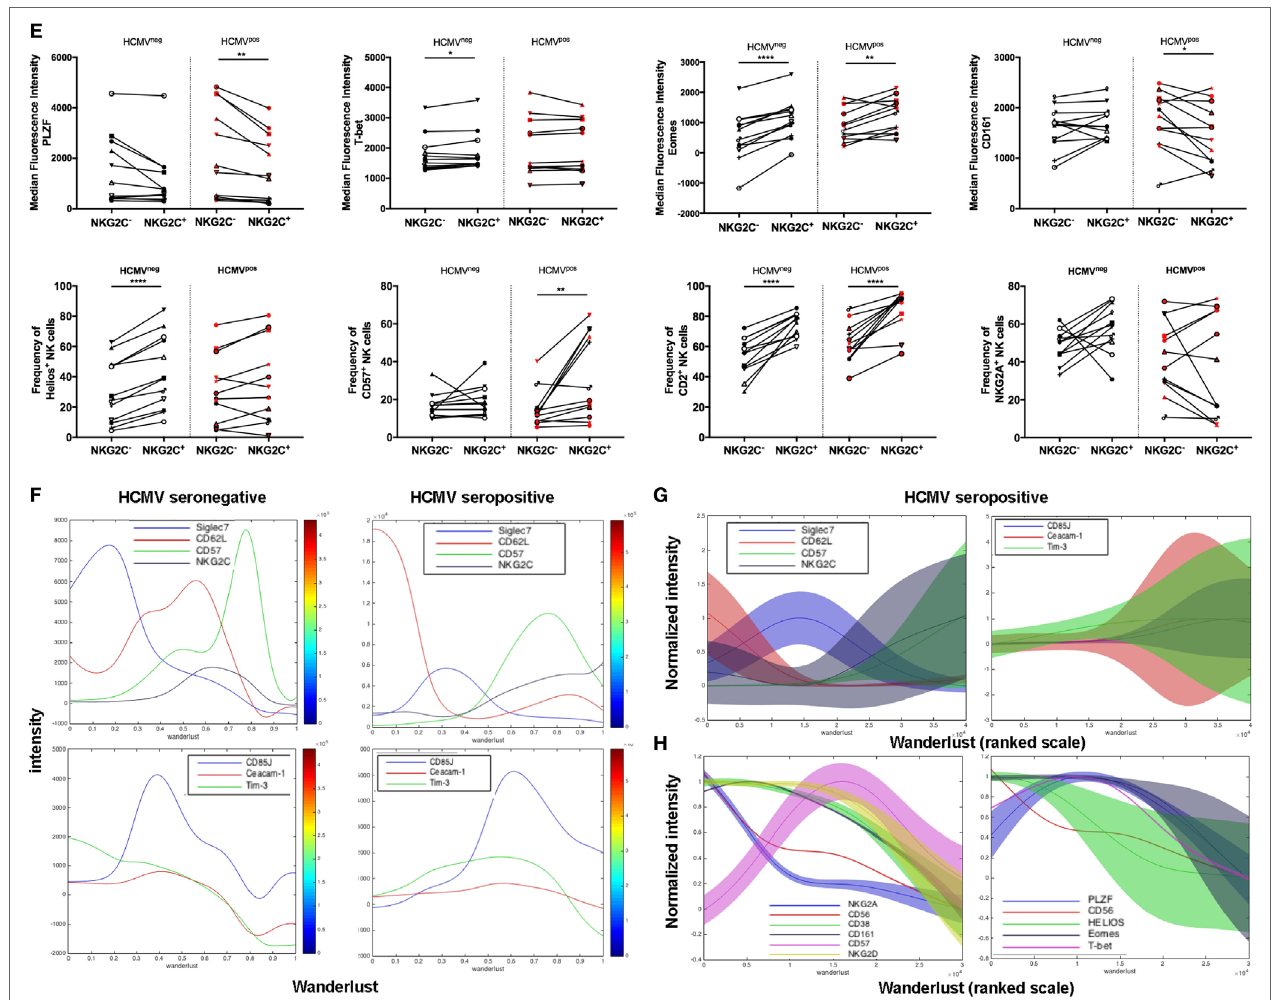
FigUre 1 | Identification of adaptive natural killer (NK) cells during human cytomegalovirus (HCMV) infection. (a) Identification of HCMV-induced human NK cells by mass cytometry. Frozen PBMCs from HCMV-seronegative and -seropositive donors were surface and intracellular stained for mass cytometry analysis. Samples were barcoded and acquired simultaneously ( n = 6). t -Distributed stochastic neighbor embedding (tSNE) analysis of 23 parametric data was performed on live CD45 + CD14 − CD19 − CD3 − CD56 + NK cells from three HCMV-seropositive and three HCMV-seronegative donors. Event density in the tSNE field for all donors compiled together in which a same number of events per donor was included. Normalized protein expression levels for CD56, CD16, CD94, NKG2C, and CD57 in tSNE field were represented in red for high expression, whereas blue represents low expression (cold-to-hot heat map). (B) The antiviral response against HCMV drives acquisition of CD85j and NKG2C in CD57 + NK cells. The frequency and phenotype of NK cells subsets were analyzed by flow cytometry on freshly isolated PBMC ( n = 28). The frequency of NKG2C + Siglec-7 − and CD85j + CD57 + CD16 + CD56 dim NK cells were positively correlated with the level of IgG antibodies specific to HCMV ( p = 0.0009; r = 0.6832 and p = 0.0199; r = 0.5158, respectively). (c) Identification of human NKG2C + adaptive NK cells by flow cytometry. PBMCs from HCMV-seronegative and -seropositive donors were surface and intracellular stained for flow cytometry analysis. Samples were acquired individually ( n = 24). tSNE analysis of 18 parametric data was performed on live lymphocytes CD45 + CD14 − CD19 − CD3 − CD56 + NK cells from 12 HCMV-seropositive and 12 HCMV- seronegative donors. Event density in the tSNE field for all donors compiled together in which 5,000 events per donor were included. Normalized protein expression levels for single parameters in tSNE field were represented with a cold-to-hot heat map. (D) Identification of human NKG2C + adaptive NK cells clusters during HCMV infection. HCMV-seropositive and -seronegative donors were compiled separately and analyzed for the repartition of clusters. (e) Phenotype of human NKG2C + adaptive NK cells in presence or absence of HCMV infection. Gated NKG2C + CD56 dim and NKG2C − CD56 dim NK cells from 12 HCMV-seropositive and 12 HCMV-seronegative donors were analyzed by flow cytometry to detect specific signature of adaptive NK cells through the surface and intracellular expression of markers previously described as associated with HCMV infection. Each donor was identified by a unique symbol for the different molecules studied. The median fluorescent intensity or frequency of markers expression was represented for molecules with continuous or bi-modal expression, respectively. The median values were compared using a Wilcoxon matched-pairs signed rank test (* p < 0.05, ** p < 0.01, *** p < 0.001, and **** p < 0.0001). (F) Characterization of human NK cell’s maturation according to Wanderlust trajectory. The Wanderlust trajectory is fixed to an arbitrary scale where the most immature NK cells (CD56 bright ) are at 0 and the most mature at 1. The traces demonstrated the relative expression patterns of Siglec-7, CD62L, CD57, NKG2C, CD85j, Ceacam-1, and Tim-3 across differentiation in HCMV-seropositive and HCMV-seronegative donors. (g,h) The expression of proteins and Wanderlust scale were normalized for the same markers than in panel (F) or for a new set of antigens such as NKG2A, NKG2D, CD38, CD161, and transcription factors promyelocytic leukemia zinc finger protein, Helios, Eomes, and T-bet. NKG2C and CD2 staining were included in the analysis but data are not shown. The variance of proteins expression was represented to illustrate heterogeneity between HCMV-seropositive